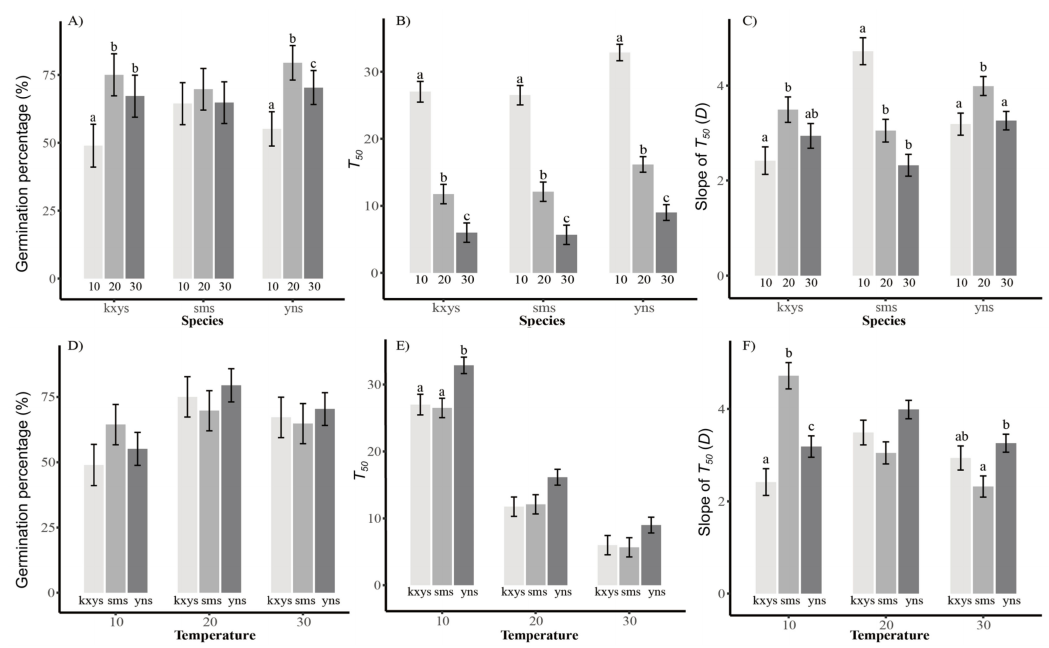
Figure 5. Germination parameters of the three pine species at 10, 20, and 30 ◦ C. ( A – C ) show G (tem- perature comparisons of germination percentage), T 50 (the time required to reach 50% germination (days)), and the slope of T 50 of each species, respectively. ( D – F ) show species comparisons of G, D, and T 50 at each temperature, respectively. Error bars indicate SE. Different letters indicate significant differences at p < 0.05. kxys: Pinus kesiya ; sms: P. kesiya var. lanbianensis ; yns: P. yunnanensis .